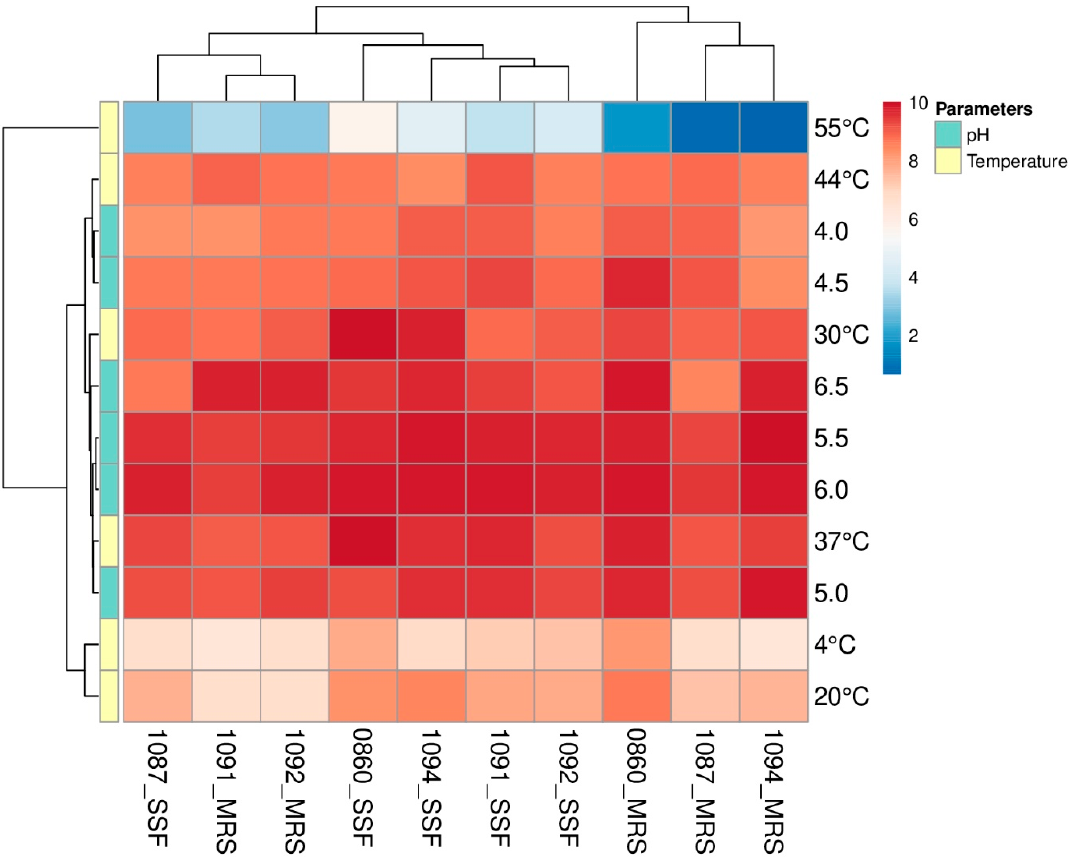
Figure 2. A heatmap presents the growth of analyzed Lactobacillus spp. ( rhamnosus Ł OCK 1087, paracasei Ł OCK 1091, reuteri Ł OCK 1092, plantarum Ł OCK 0860 and pentosus Ł OCK 1094) which